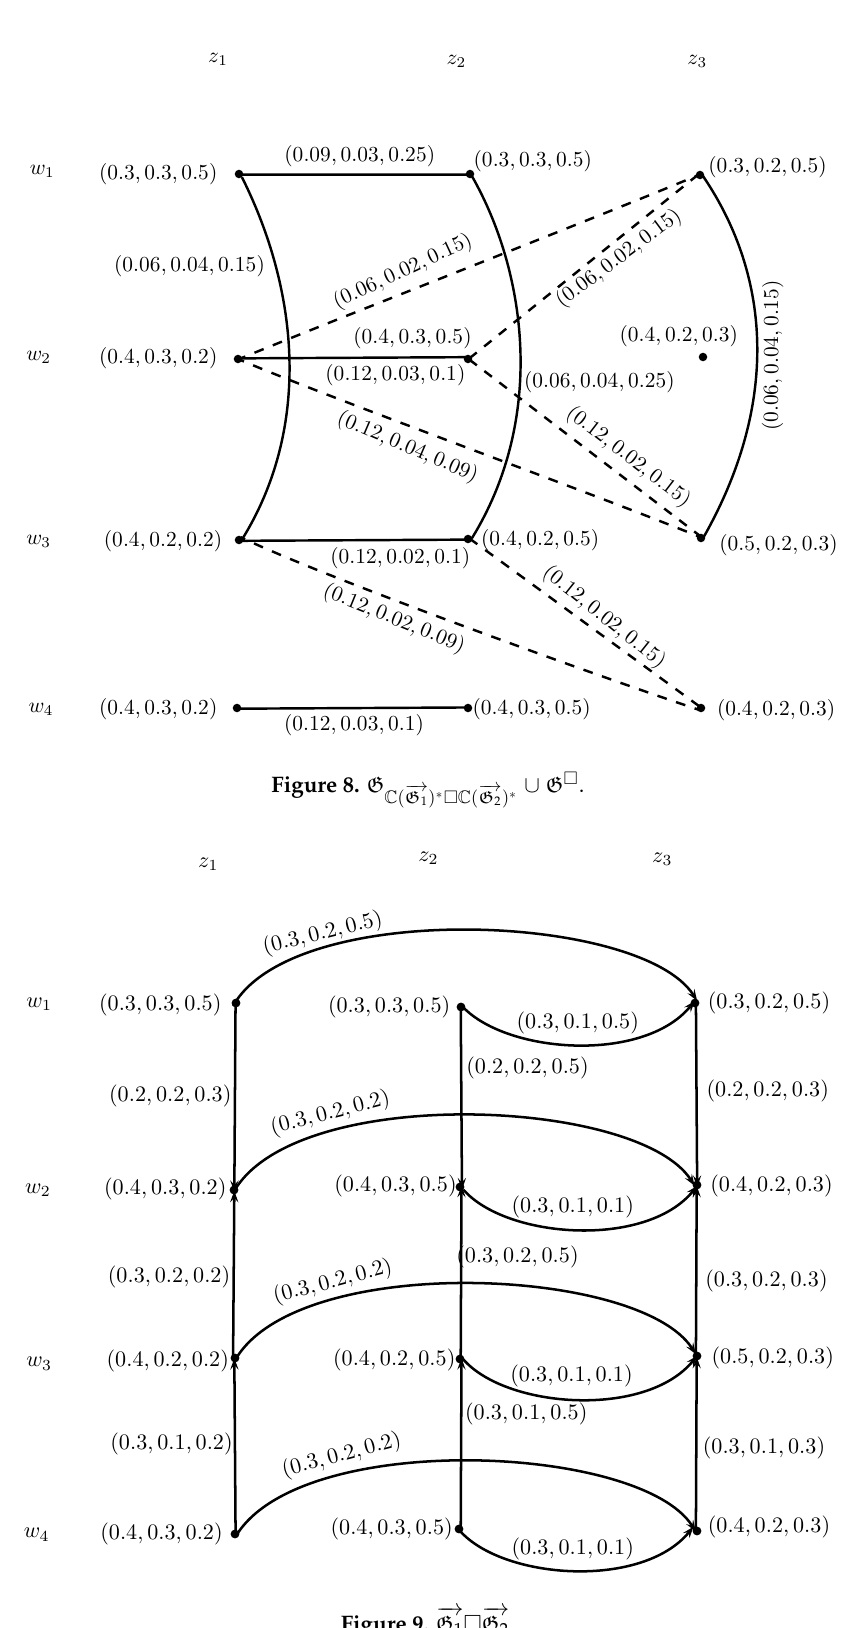
Figure 9. −→ G 1 (cid:3) −→ G 2